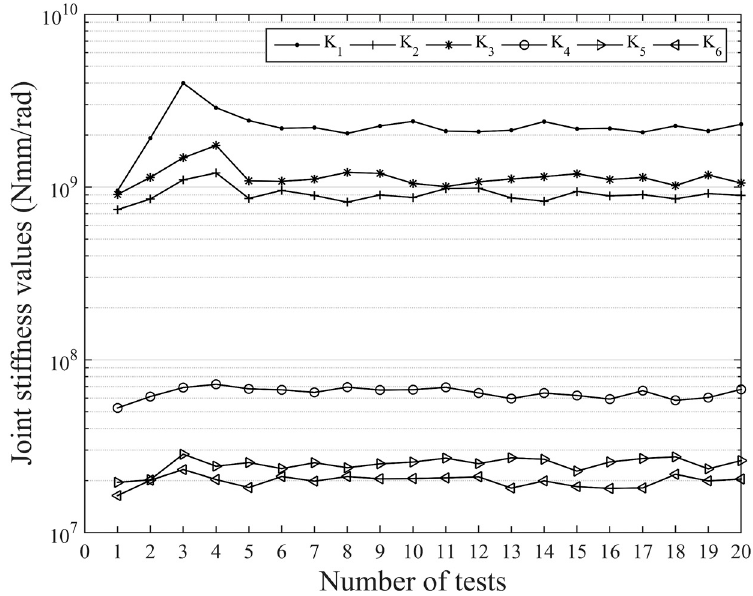
Figure 10. Robustness of the tests. Table 5. The values and errors of joint stiffness.